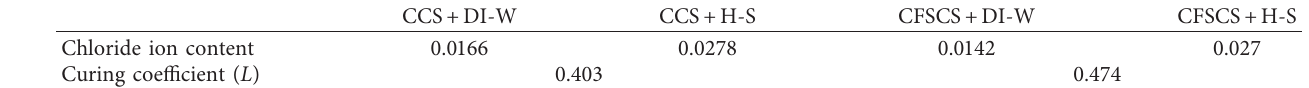
Table 5: Chlorine ion content of mortar samples at 28d